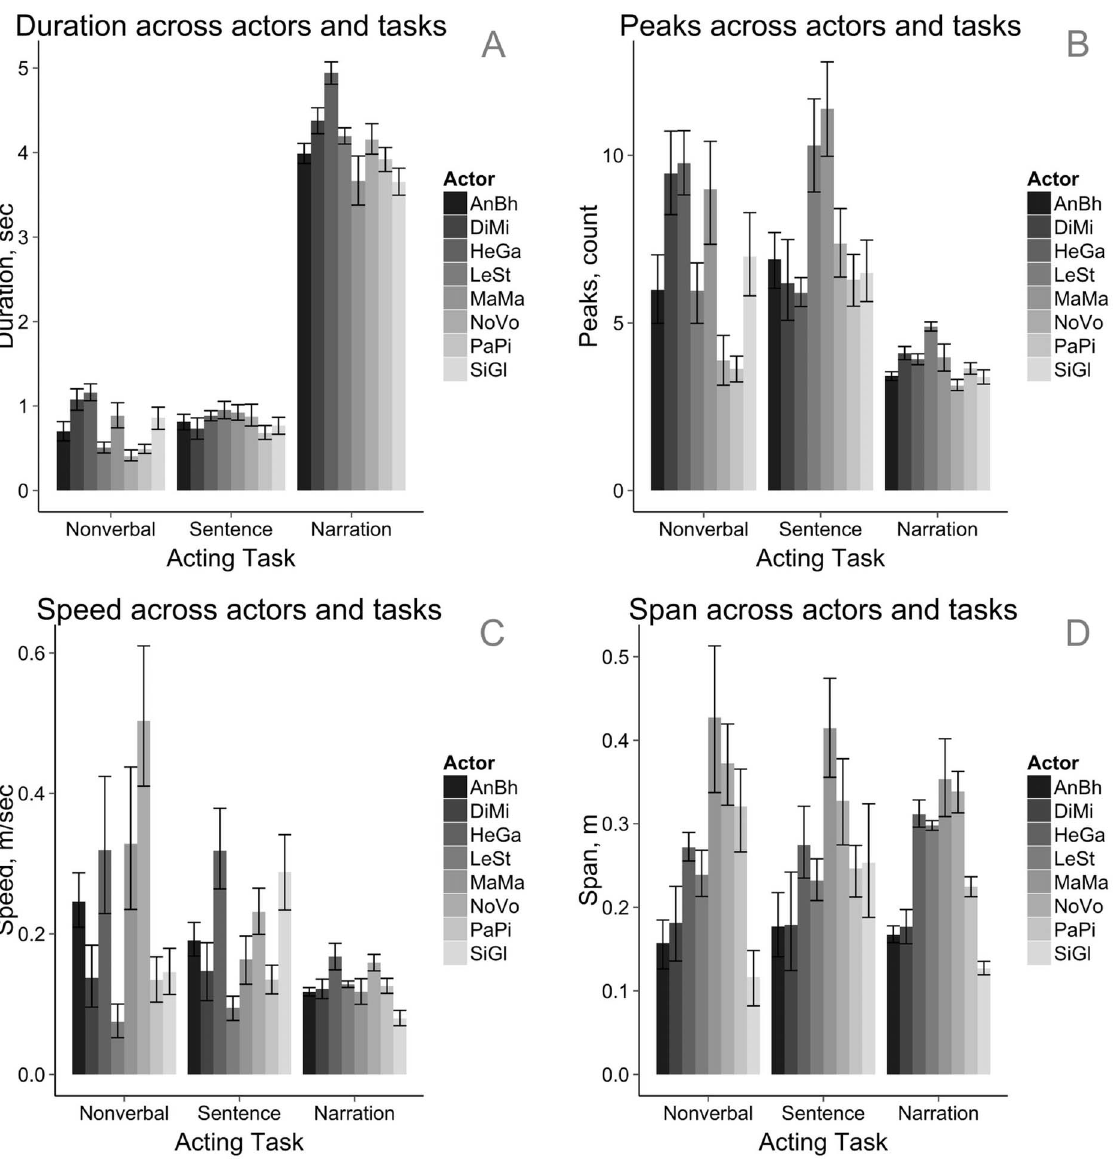
Figure 7. Physical properties of motion sequences across acting tasks and individual actors. All error bars represent 95% CI. The panels show: (A) Duration, sec; (B) Peaks in motion trajectories of right and left wrists across acting tasks; (C) Average motion speed; (D) Average motion span. As the bar plots show, physical properties of motion sequences depend both on the acting tasks and on the individual